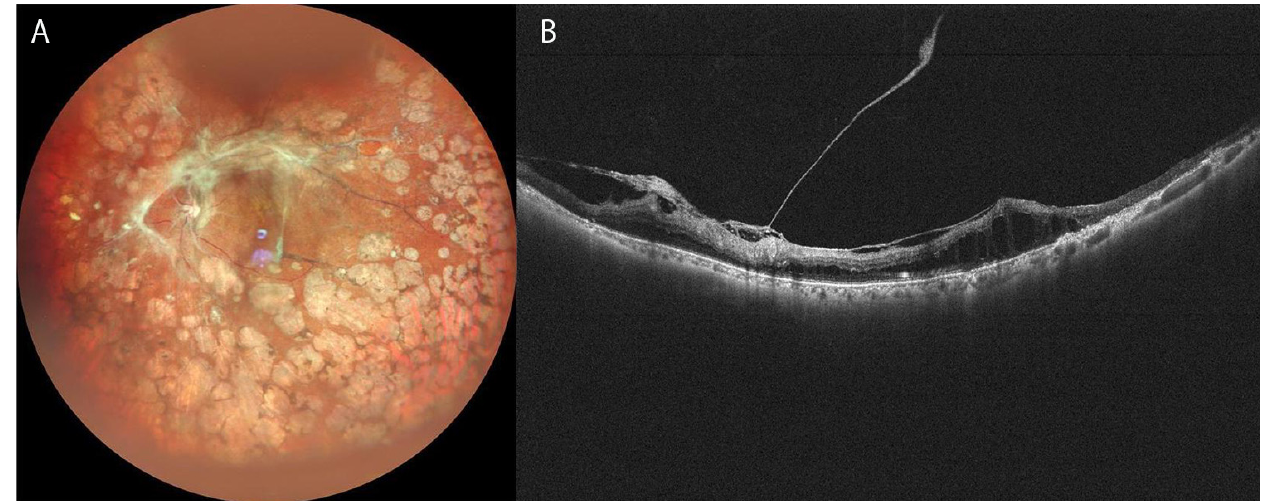
Figure 1. Ultra-widefield (UWF) fundus or OCT images of severe proliferative diabetic retinopathy of 74-year-old woman. ( A ): UWF image of Mirante, ( B ): UWF OCT of Canon S1.